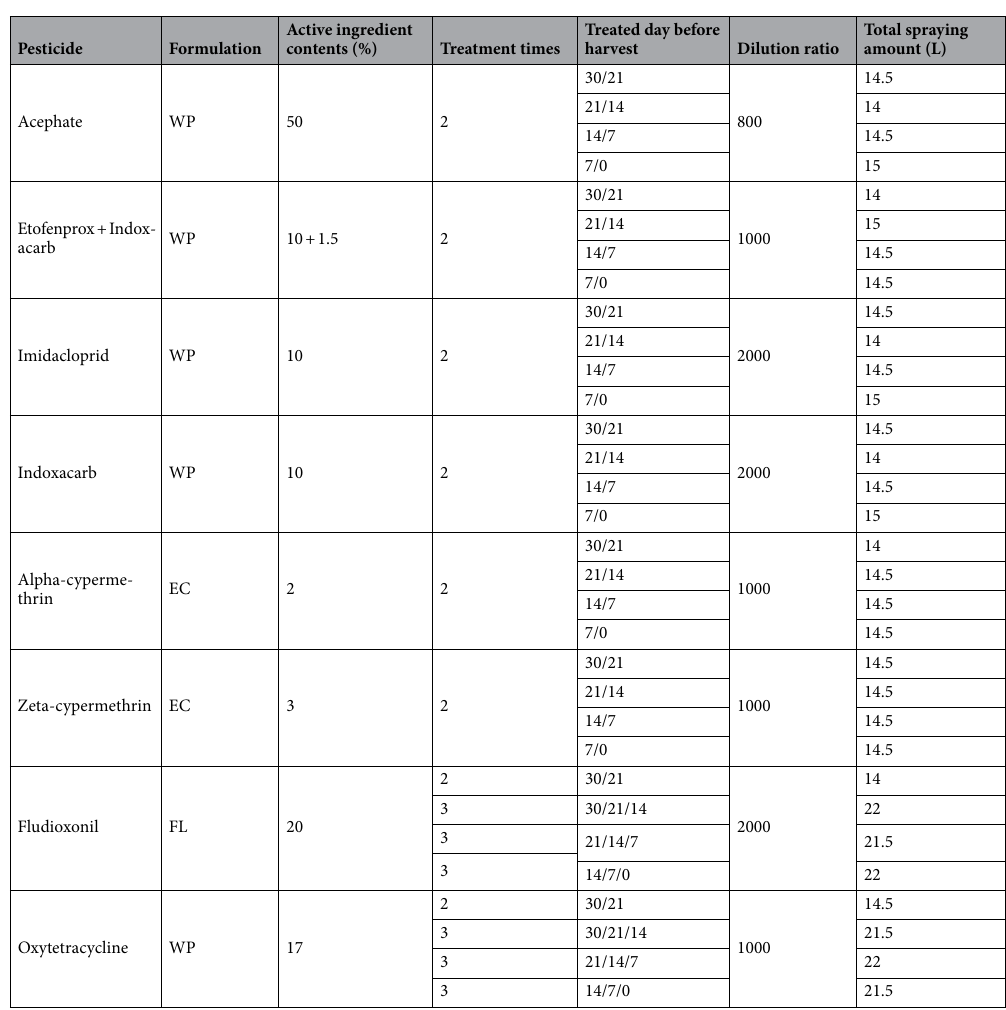
Table 1. Pesticide treatment of Brussels